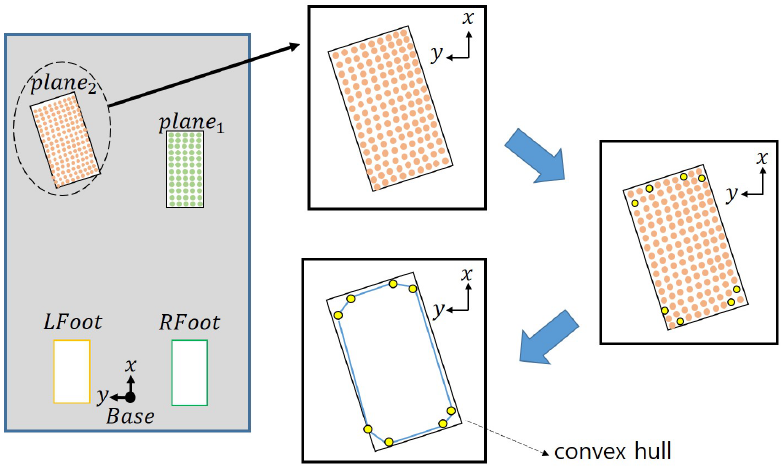
Figure 4. Points that make up a convex hull based on a given point